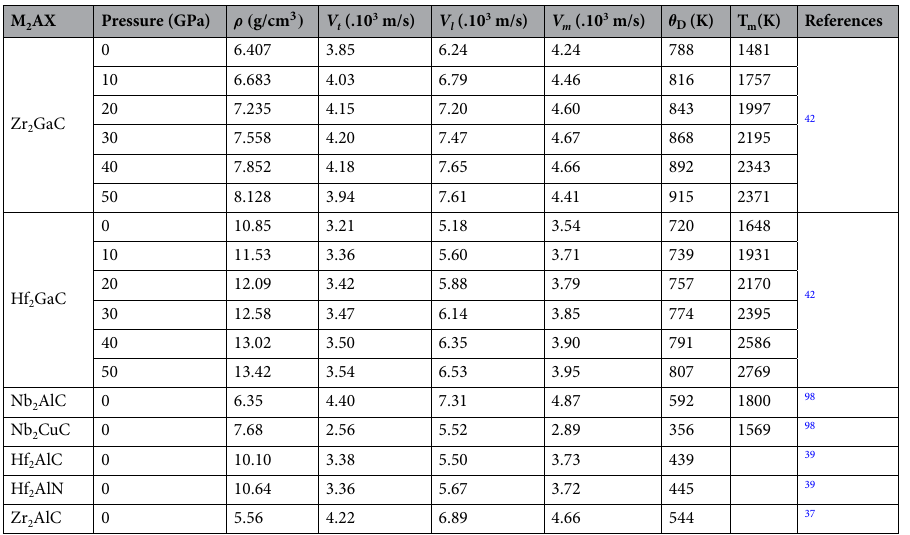
Table 5. The computed density (ρ), transverse (V t ), longitudinal (V l ), mean (V m ) sound velocities, and Debye’s temperature (